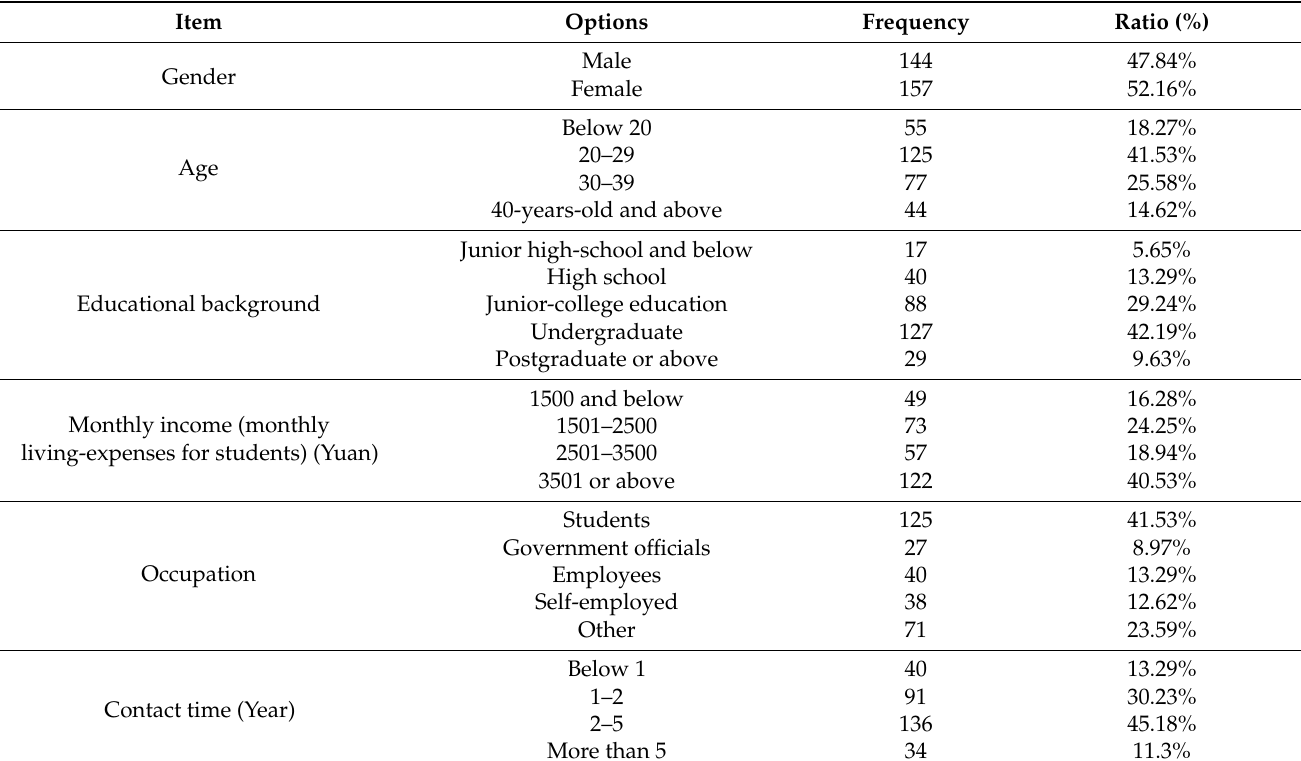
Table 2. The statistics and analysis table of